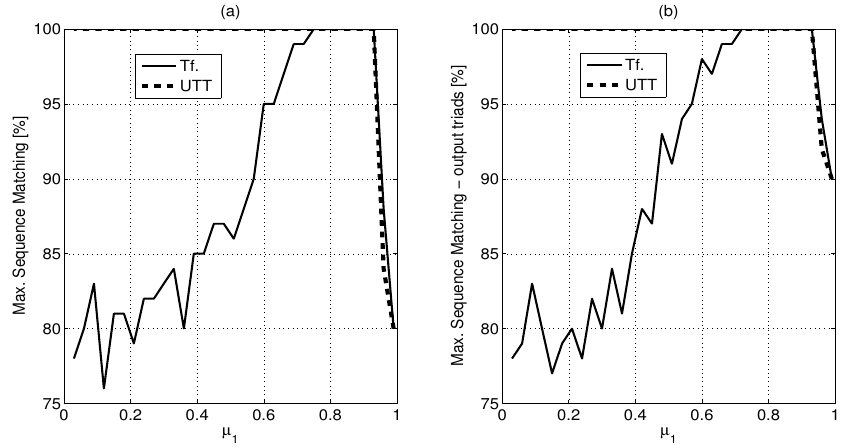
Figure 9. Wilde Jagd—maximal sequence matching of transformations ( a ) and triads ( b